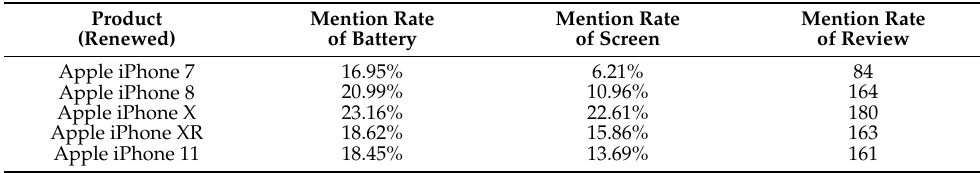
Table A4. Fine-Grained Sentiment Analysis upon LFSC-A.